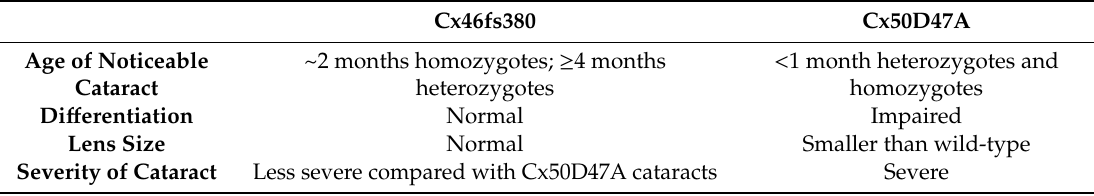
Table 1. Di ff erences between the characteristics of Cx46fs380 and Cx50D47A lenses